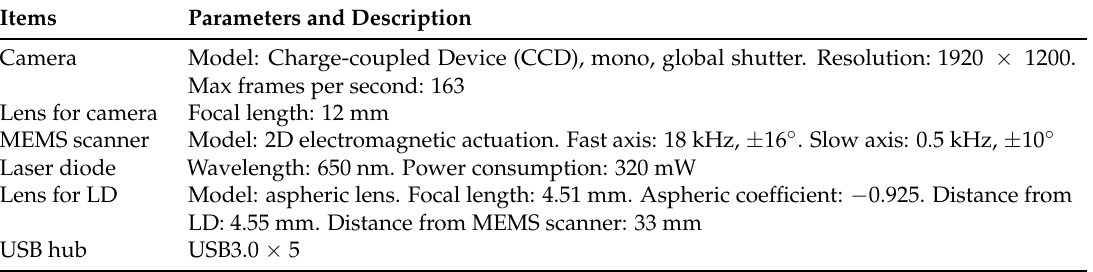
Table 1. Parameters and description for experimental components.